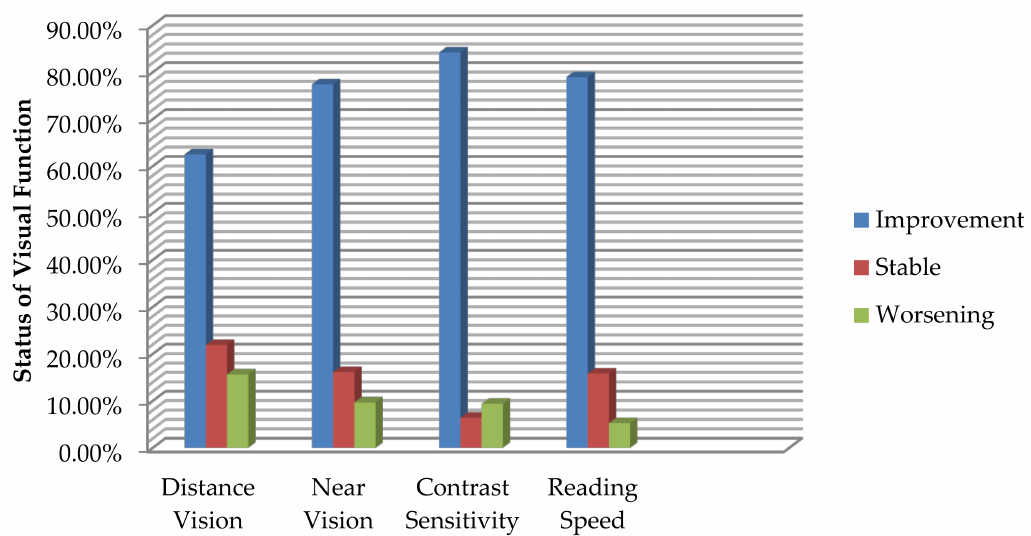
Figure 1. Status of distance visual acuity, near visual acuity, contrast sensitivity after 6 months: Improvement = 0.1 logMAR or more improvement; Stable = less than 0.1 logMAR change; Worsening = 0.1 logMAR or worse. Status of reading speed after 6 months: Improvement = 10 words per minute or more improvement; Stable = less than 10 words per minute change; Worsening = 10 words per minute or worse.